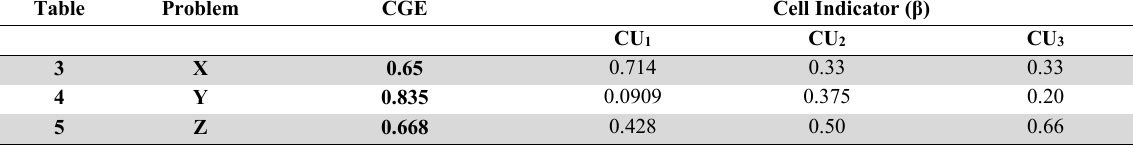
Problem CGE Machine Utilization(MU)